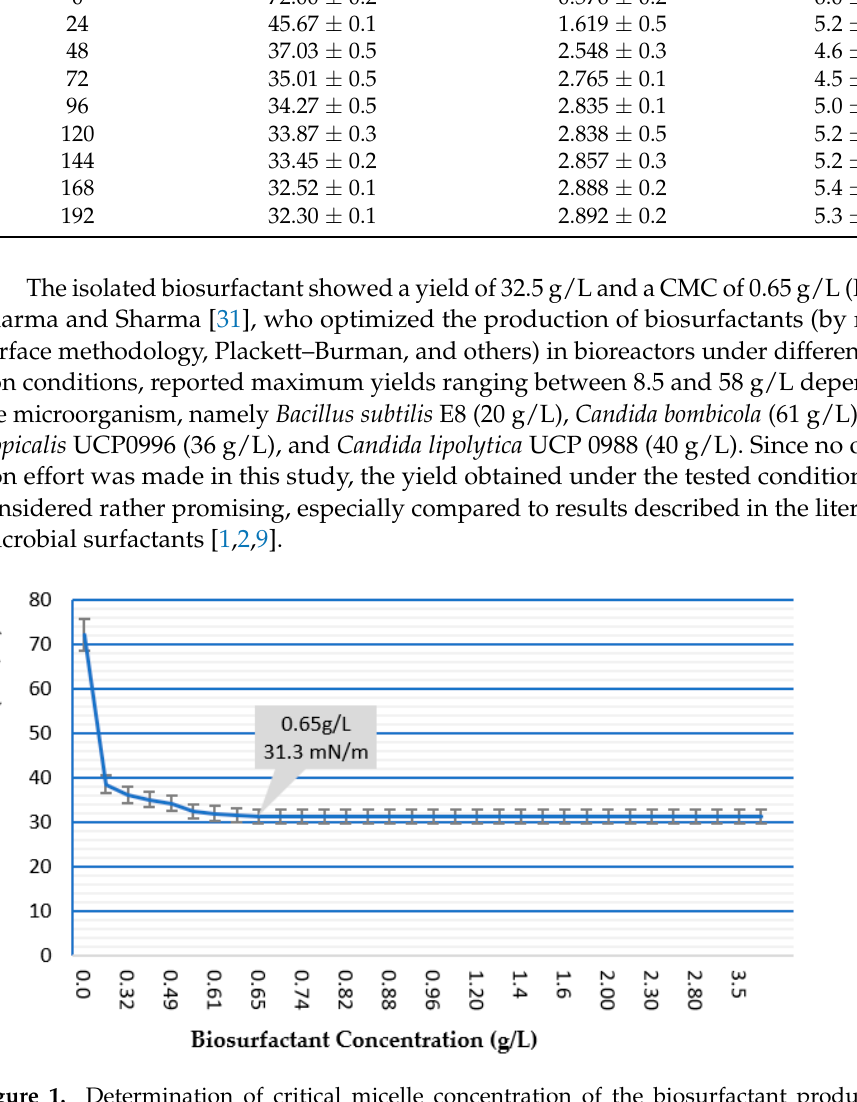
Figure 1. Determination of critical micelle concentration of the biosurfactant produced from Star- merella bombicola ATCC 22214. Starmerella bombicola ATCC